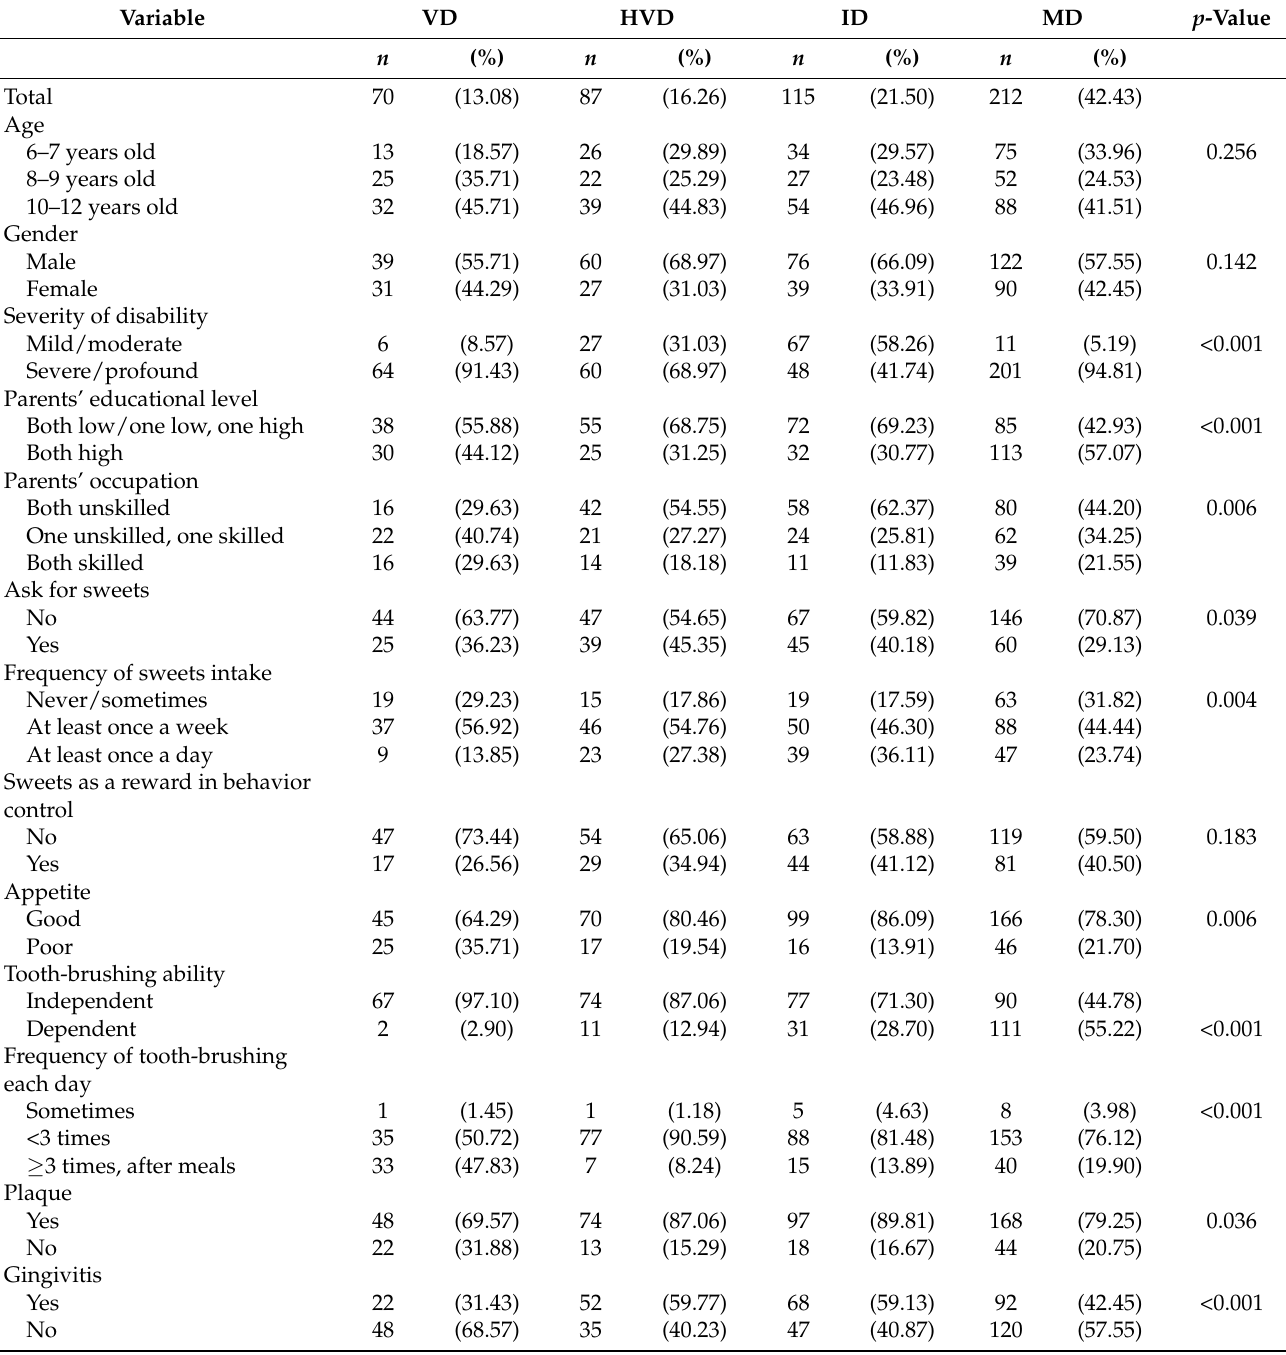
Table 3. Demographics, dietary and tooth-brushing habits, and oral hygiene status by classification of disability among children with